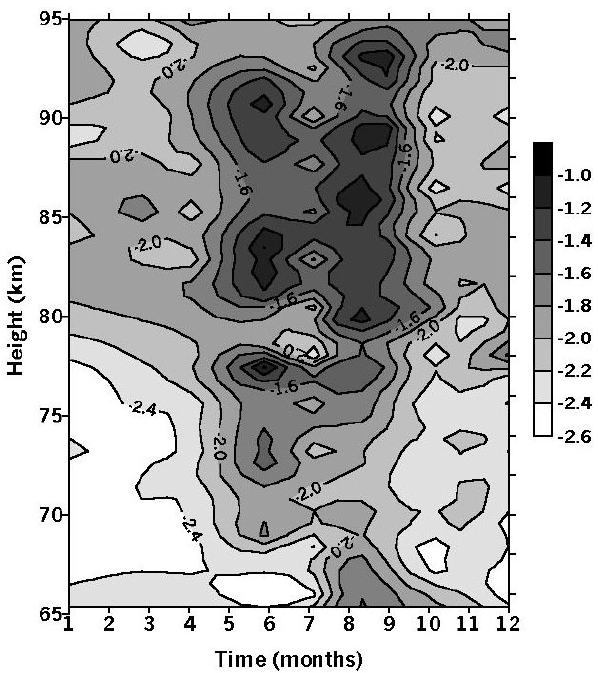
Fig. 3. Height-time section of energy dissipation rates ( ε ) in the mesosphere over Gadanki. The contour intervals are .2 W/kg (log ε ).